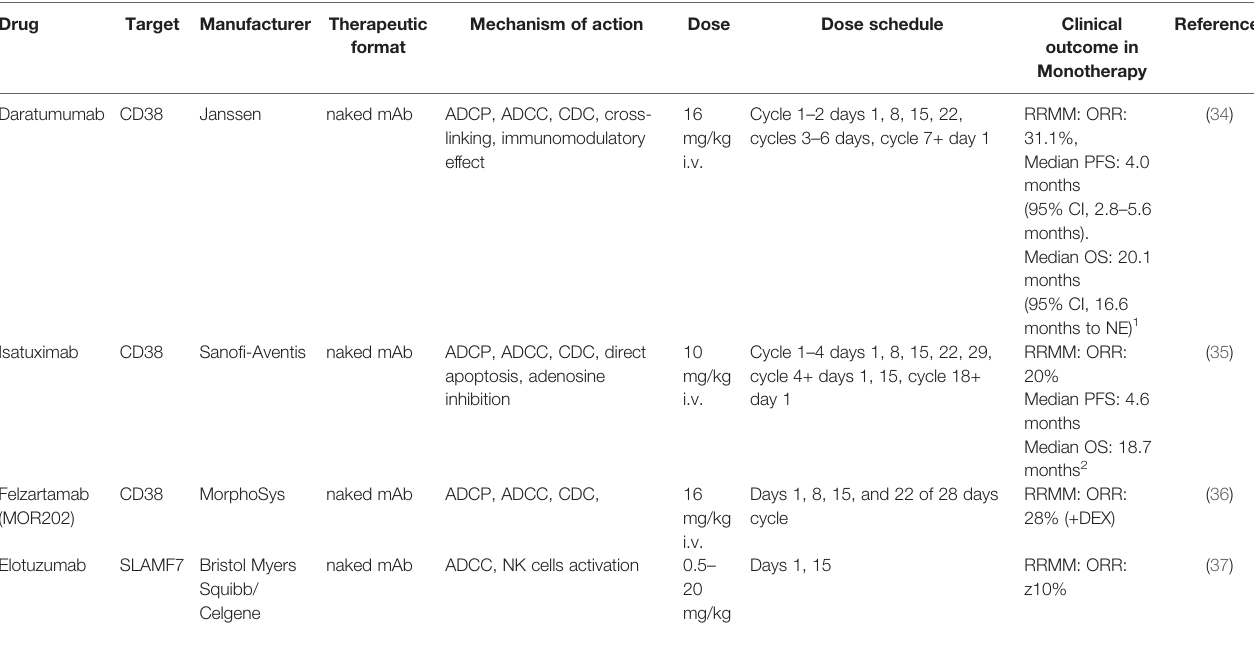
TABLE 2 | Monoclonal antibodies against CD38 and SLAMF7 (Major clinical trials with published data). Drug Target Manufacturer Therapeutic Mechanism of format